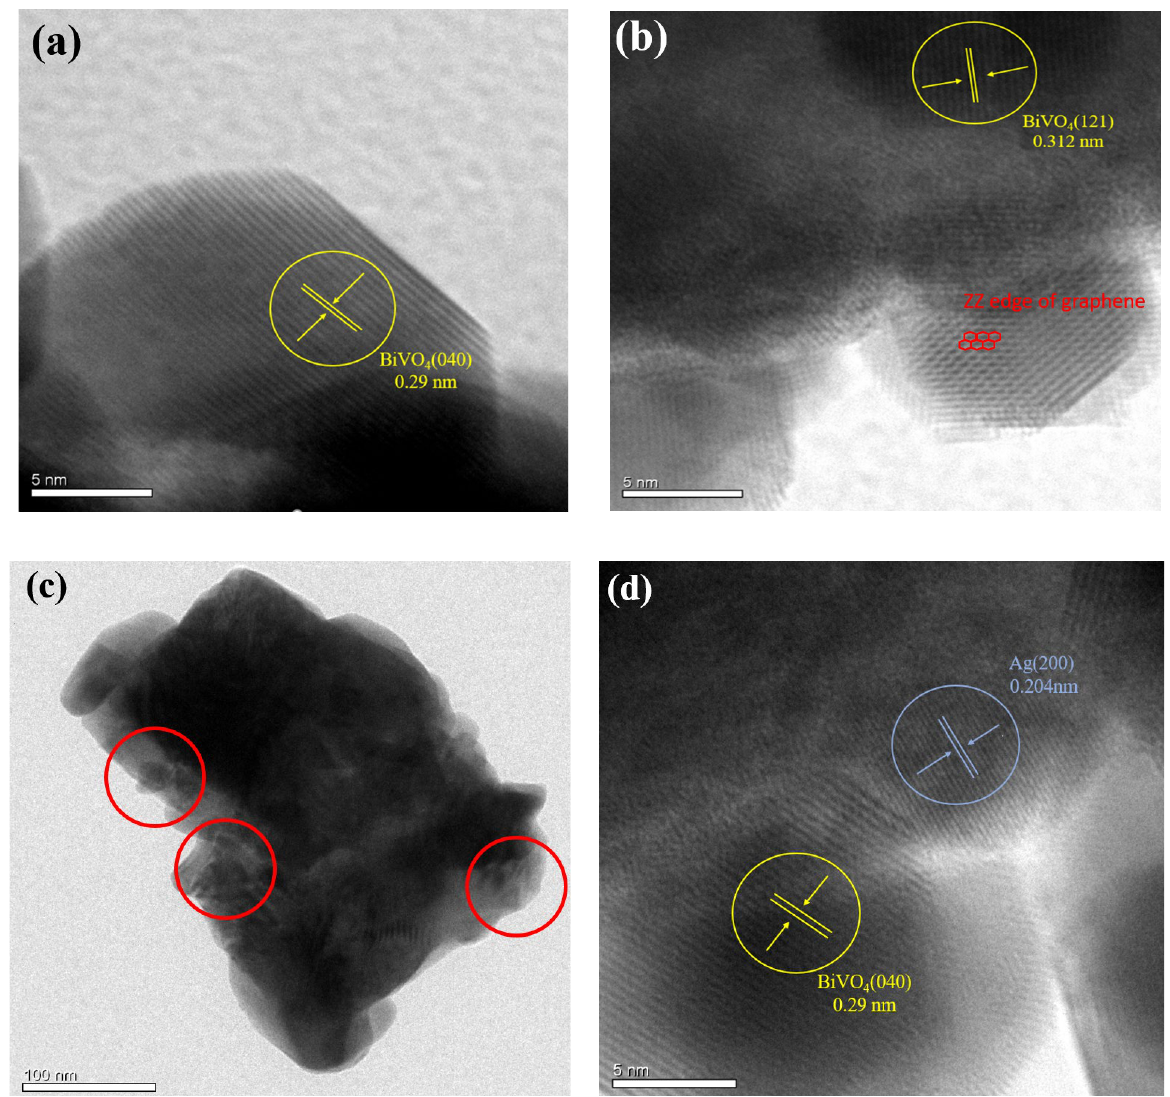
Figure 3. TEM images of the as-prepared photocatalysts. ( a ) HR-TEM image of pure BiVO 4 ; ( b ) HR-TEM image of 7 wt% graphene/BiVO 4 ; ( c ) low-resolution TEM image; ( d ) HR-TEM image TAgNPt/graphene/BiVO 4 with 0.003 wt% TAgNPts and 7 wt% graphene.